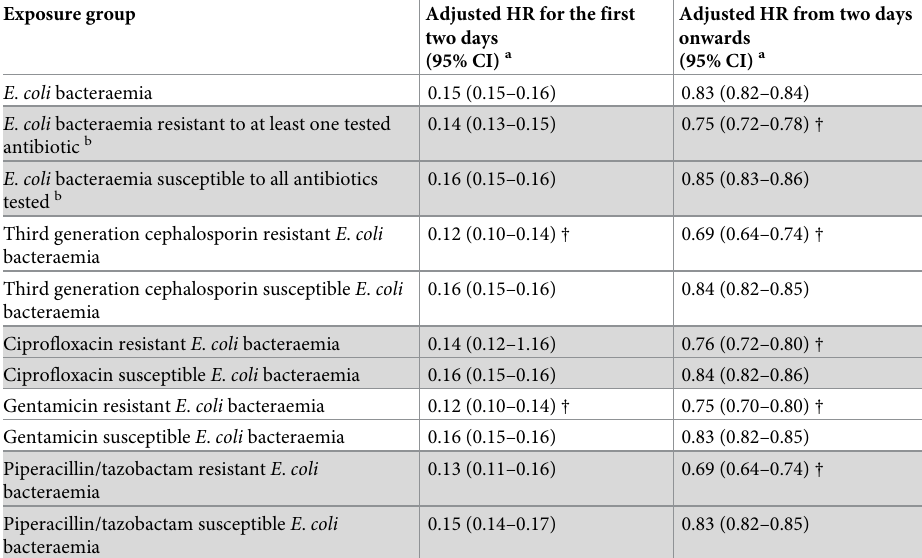
Table 5. Daily risk of experiencing discharge